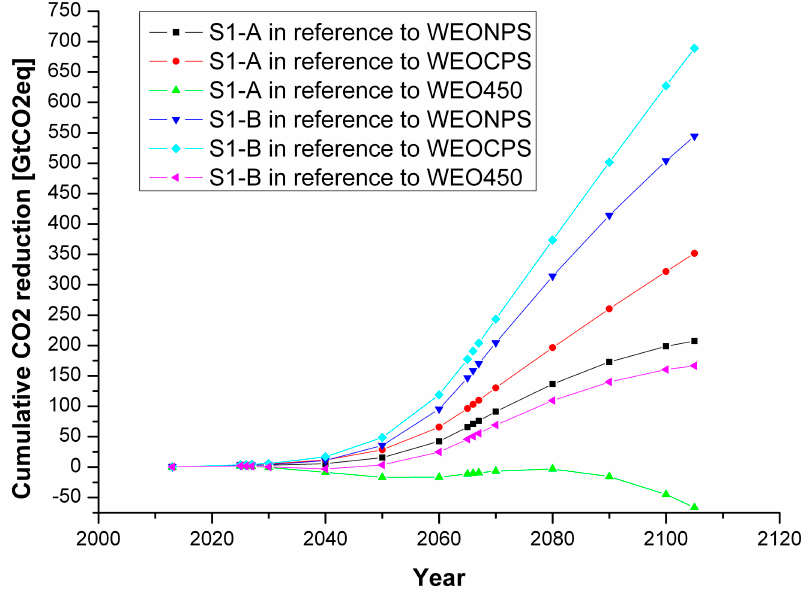
Figure 2. Cumulative CO 2 reduction for scenario S1, sub scenarios A and B, in comparison to WEO 2015 extrapolation.